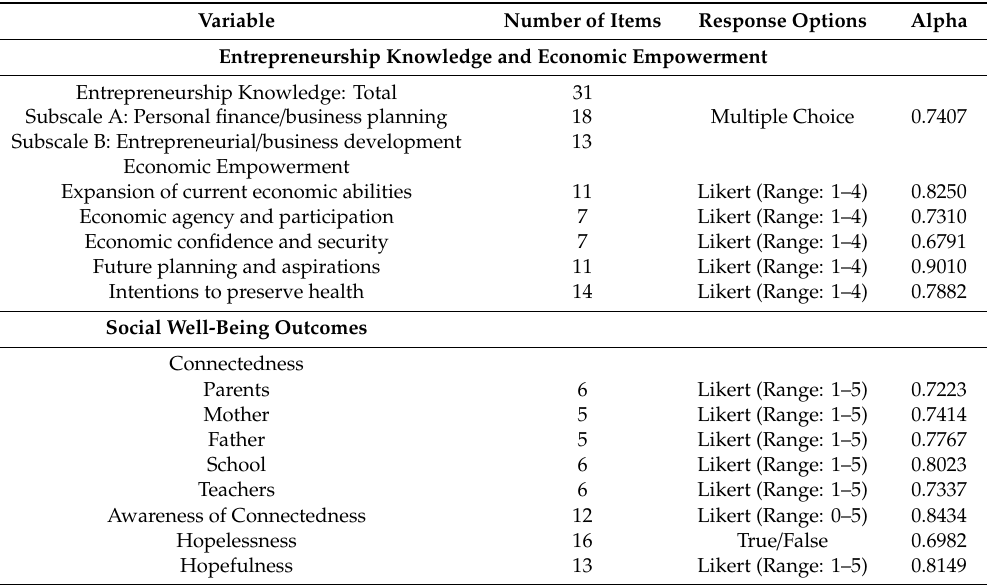
Table 1. Description of the outcome variables by